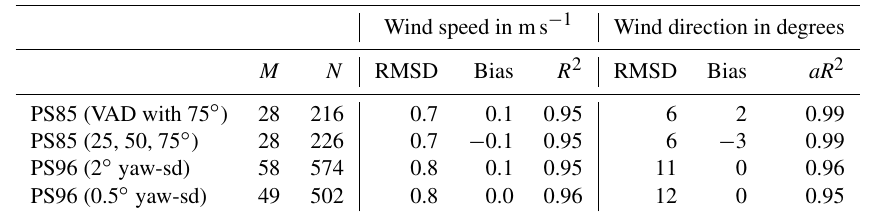
Figure 6. RMSD, bias and number of used radio soundings ( N ) by height of wind speed and direction for PS85 (a) and PS96 (b) . Different colours show different SNR thresholds ( − 23 blue, − 20dB green, − 17dB orange). Only scans with an elevation of 75 ◦ were used. Table 2. Statistics for all available lidar data compared to radio soundings. M indicates the number of used radio soundings. N indicates the number of compared measurements ( N is lower for the wind direction because up to six cases with wind speed < 0.5ms − 1 are removed). PS85 computed for a − 17dB SNR threshold with only 75 ◦ elevation scans (first column, as shown in Fig. 6) and with all 25, 50 and 75 ◦ (second column). PS96 was computed for − 20dB SNR threshold with the default case (standard deviation of yaw angle below 2 ◦ for each ray; third column, as shown in Fig. 6) and a stricter case (standard deviation of yaw angle below 0.5 ◦ for each ray; fourth column). aR is the correlation coefficient for angular